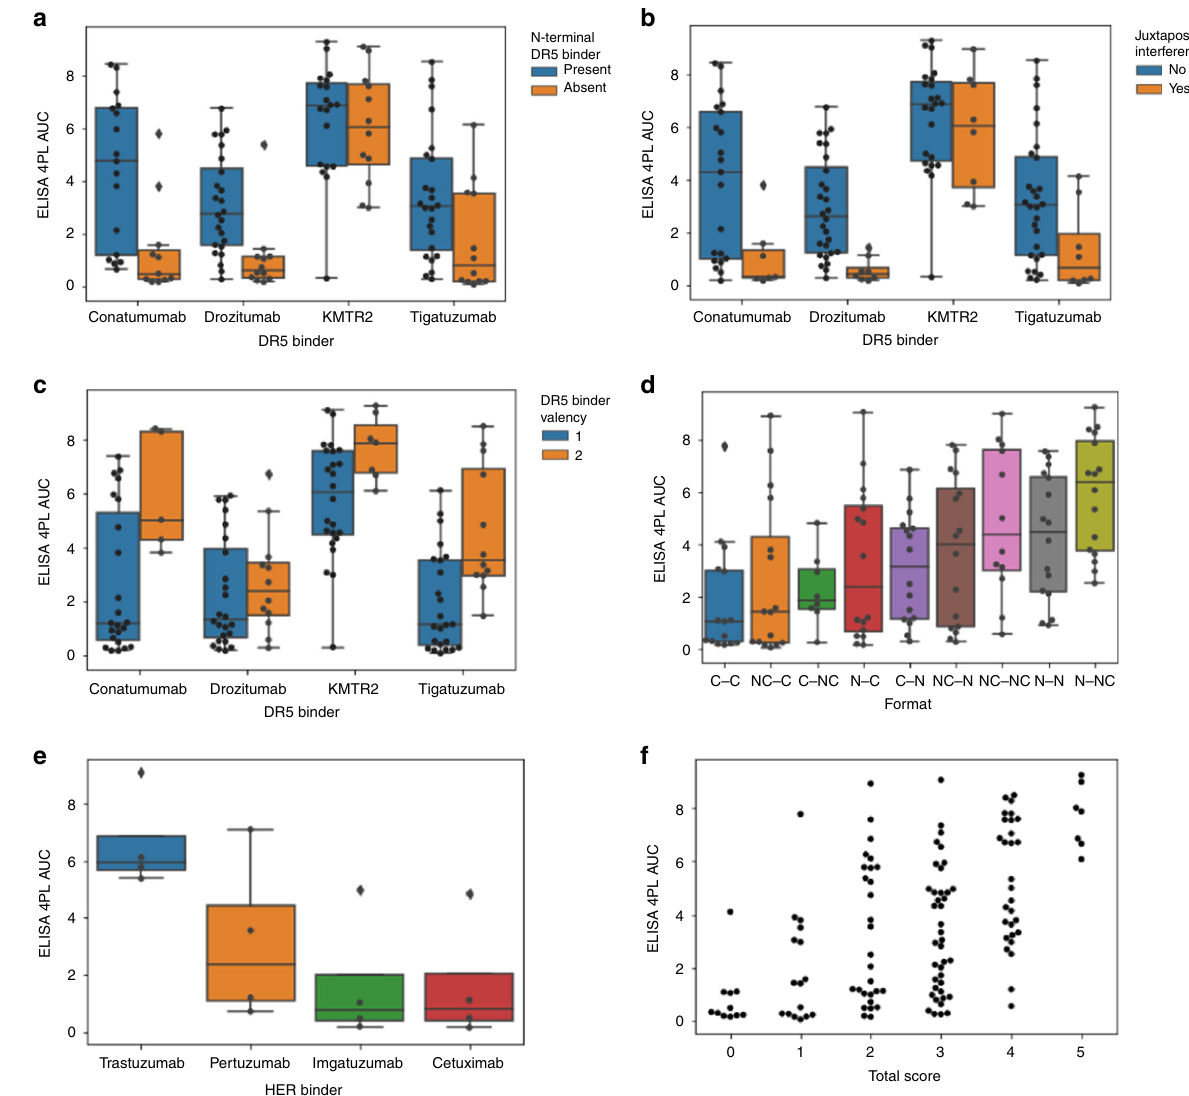
Fig. 6 Format de fi nes function — the importance of combining suitable binders and formats. a Reduction of dual binding functionality in bsAbs that lack N-terminal DR5 binding entities. b C-terminal juxtapositioned Her binders affect DR5 binding of monovalent C-terminal DR5 binders; c Bivalent Conatumumab, Tigatuzumab, and KMTR2 enhances Her-DR5 dual binding; d the N – NC format works without exception for all Her – DR5 binder combinations; e the N – C format works for Trastuzumab combined with DR5 binders in all formats but is not favorable for other Her binders; f screening in fi nal format identi fi es also combinations that would be “ excluded ” by strictly rule based approaches. For example, Trastuzumab combined with KMTR2 in C-position show good dual binding despite of bad rule adherence (top entities in column 1 – 3), and Pertuzumab or Trastuzumab combined with Drozitumab show only marginal dual binding despite of good rule adherence (bottom entities in column 5). Rules applied were (1) DR5 binder present at N-terminus; (2) without C-juxtaposition interference; (3) DR5 valency = 2; (4) HER binder present at N-terminus; (5) DR5 binder = KMTR2. For each construct 1 point was assigned for each ful fi lled criterion and the total score compared to the ELISA 4PL AUC outcome (AUC determined from N = 9 dose – response sets each, Supplemental Figs. 3 and 4). A description of the scoring rubric applied to rank individual members of the bsAb binder – format matrix is provided in the methods section. Data points represent the values of individual molecules, Boxplots indicate 25th percentile (box bottom border), 75th percentile (box top border), median (horizontal line in box), “ minimum ” [25th percentile − 1.5 * interquartile range] (bottom whisker), “ maximum ” : [75th percentile + 1.5 * interquartile range] (top whisker), and outliers